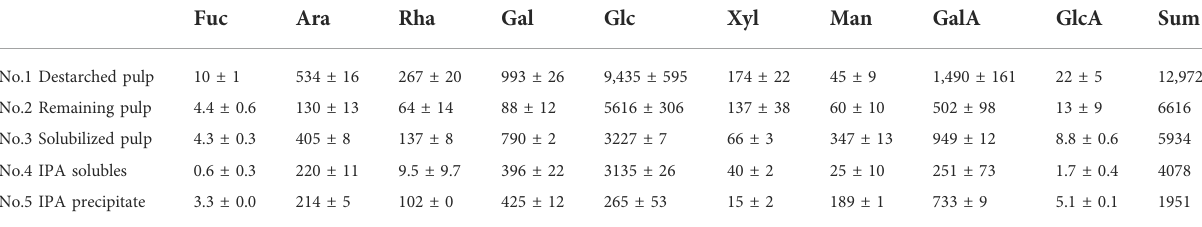
TABLE 1 Monosaccharide composition (mg/20 g DW) in dehydrated de-starched pulp determined at different stages of extraction, described in Figure 1 and notably in Figure 2, using enzymatic extraction and 70% isopropanol (IPA) treatment. Values are averages of three independent measurements ±s.d.